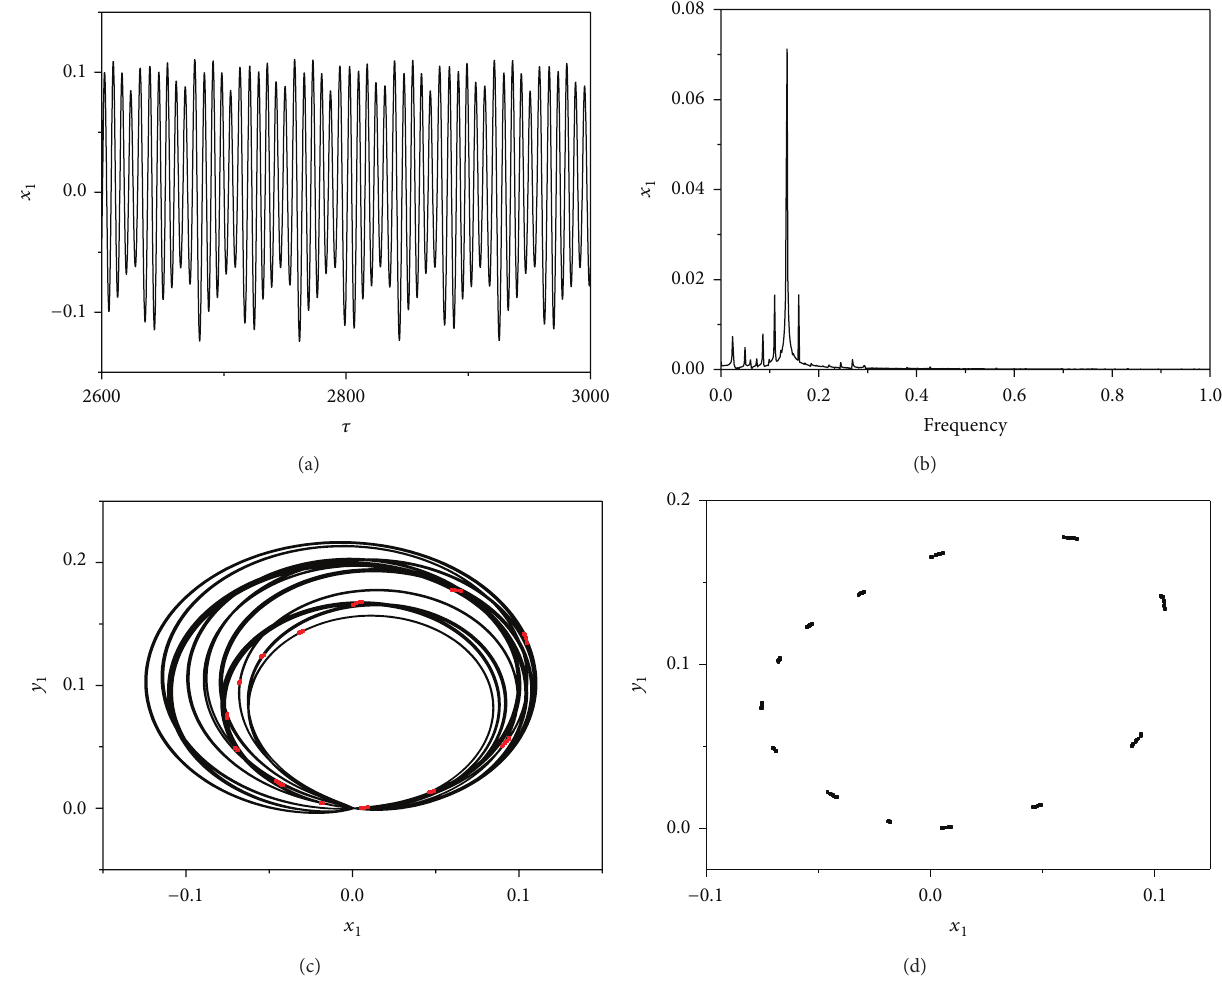
Figure 8: See 𝜔 = 1.12 . (a) Displacement response. (b) Frequency spectrum. (c) Rotor orbit. (d) Poincar´e